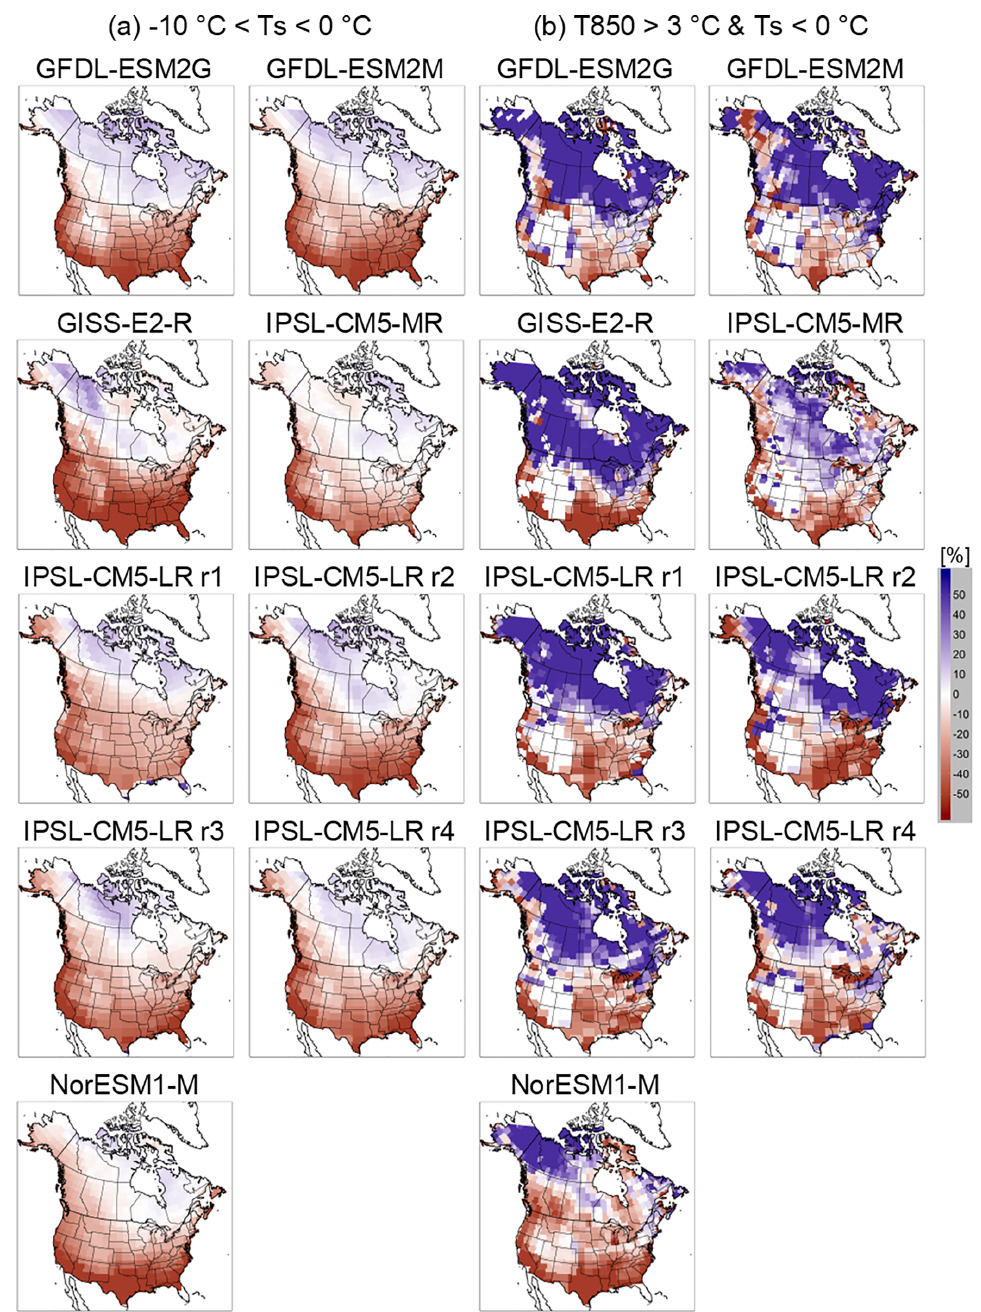
Figure 8. Projected changes to frequencies of (a) − 10 ◦ C<Ts<0 ◦ C and (b) T850>3 ◦ C and Ts<0 ◦ C from nine GCMs at their + 2 ◦ C GMTC level relative to the baseline period,